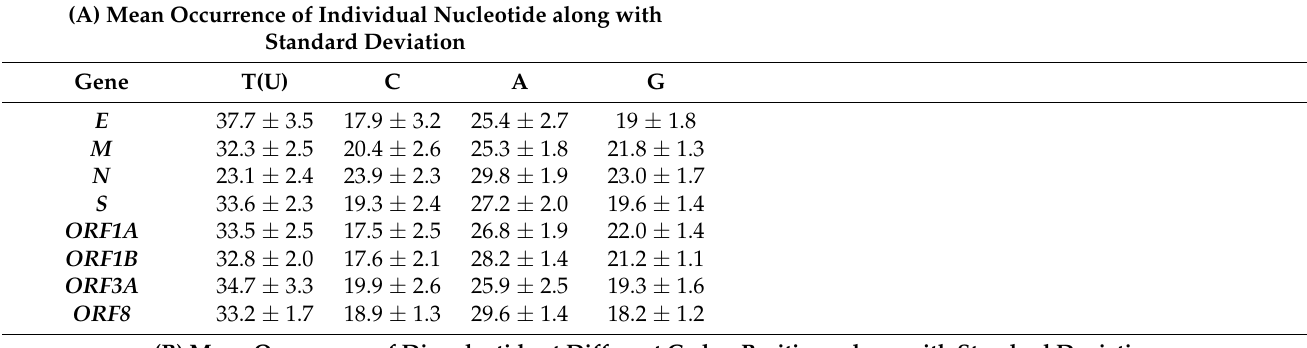
Table 1. Mean and standard deviation of nucleotides and dinucleotides in different gene sets along with standard deviation. (A) Mean Occurrence of Individual Nucleotide along